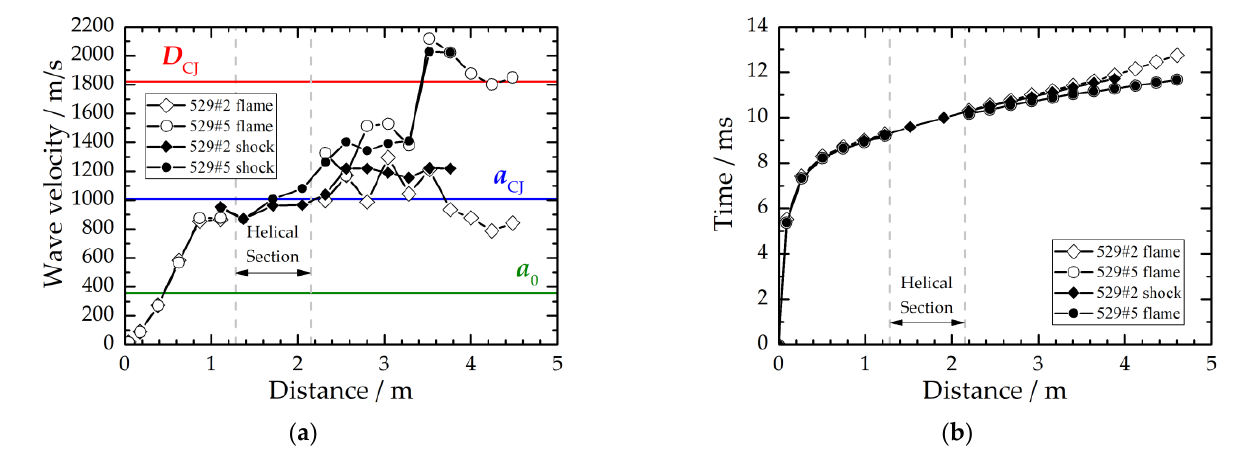
Figure 13. ( a ) Lead shock wave (closed symbols) and reaction front (open symbols) velocities vs. the distance along the pulsed detonation tube and ( b ) the corresponding time-distance diagram for two experiments (529#2 and 529#5) with the same stoichiometric methane–hydrogen–air mixture at normal initial conditions. Fuel: 65%vol. methane + 35%vol. hydrogen.